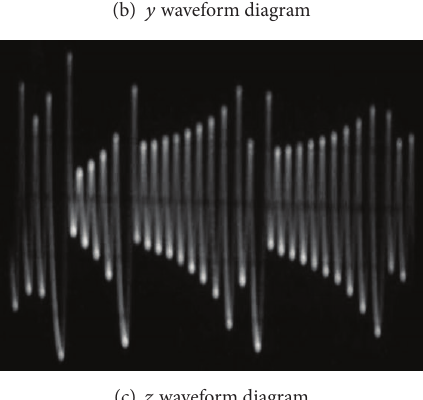
Figure 9: The output waveform pictures of improved Lorenz circuit experiment board.